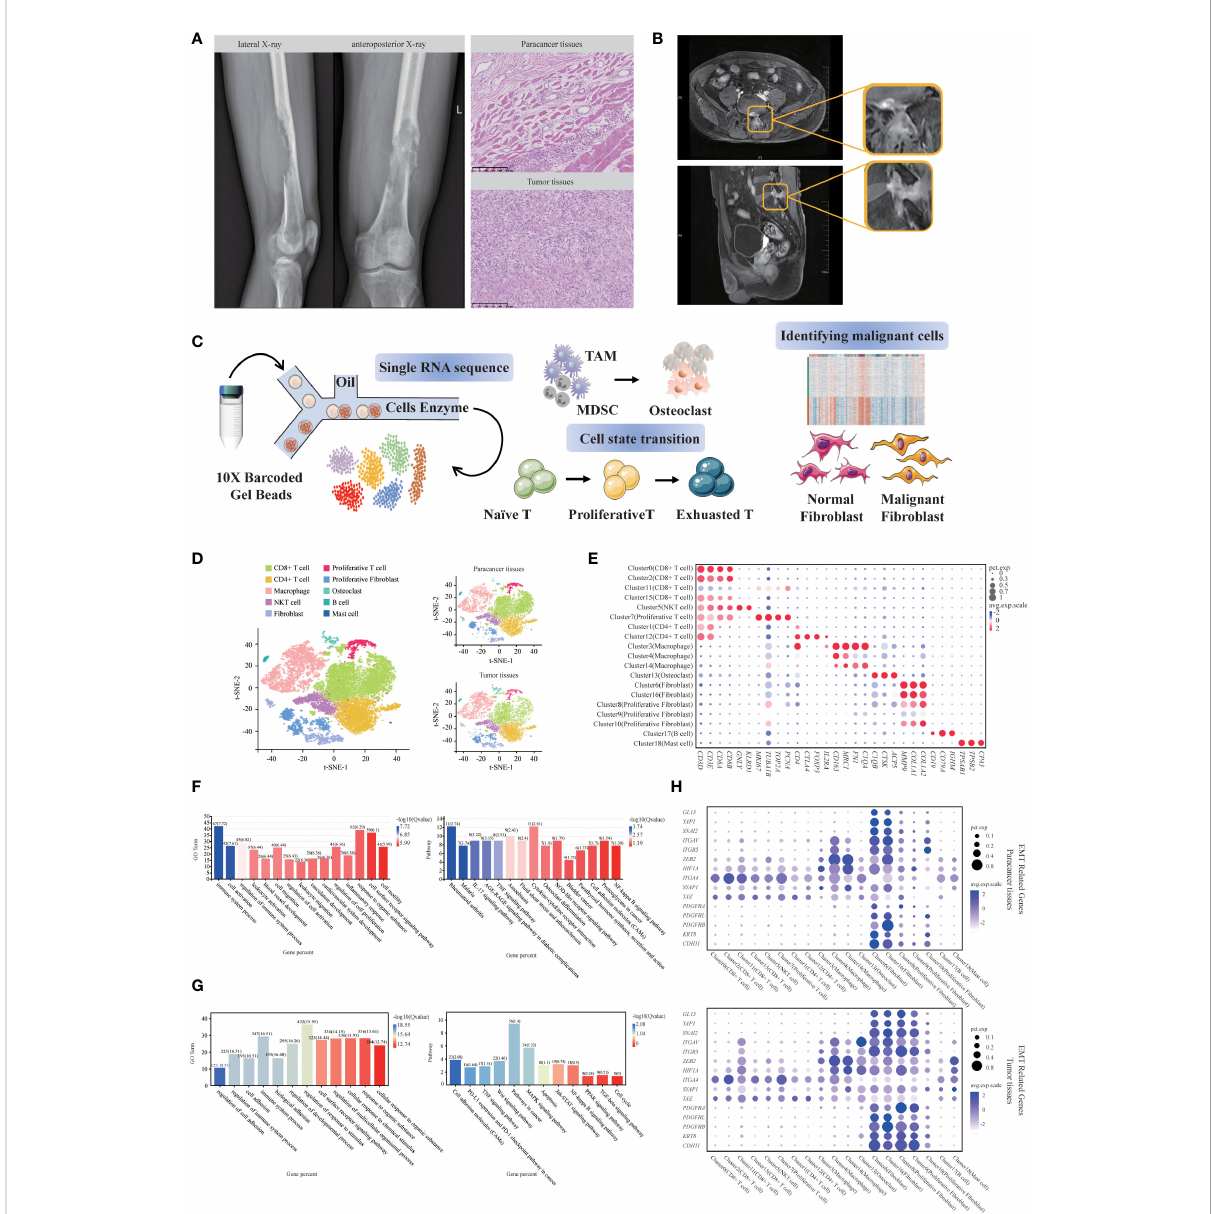
FIGURE 1 Single-cell transcriptomic analysis of SUPS. (A) Bone destruction of the left lower femur with a soft tissue mass (Lateral X-ray fi lm; Anteroposterior X-ray). H&E staining of the tumor tissues and paracancer tissues (Scale bar 250 m m). (B) MR medical impact (upper: pelvic plain scan; lower: femoral plain scan). (C) Schematic diagram of the experimental design. (D) The t-distributed stochastic neighbor embedding (t- SNE) plot of the 10 identi fi ed main cell types in SUPS lesions, with each cell color-coded according to its associated cell type. (E) Dot plot showing the 30 signature gene expressions across the 10 cellular clusters. The size of dots represents the proportion of cells expressing the particular marker, and the spectrum of color indicates the mean expression levels of the markers (log1p transformed). (F) GO and KEGG enrichment analyses were performed for DEGs in SUPS between tumor tissues and paracancer tissues. Representative signi fi cantly enriched function processes are shown. (G) GO and KEGG enrichment analyses were performed for DEGs in non-immune cells between tumor tissues and paracancer tissues. (H) Expression of EMT-related genes were shown for each cluster of paracancer tissues and tumor tissues. Dot size corresponded to the percentage of cells in the cluster expressing a gene, and dot color corresponded to the average expression level for the gene in the